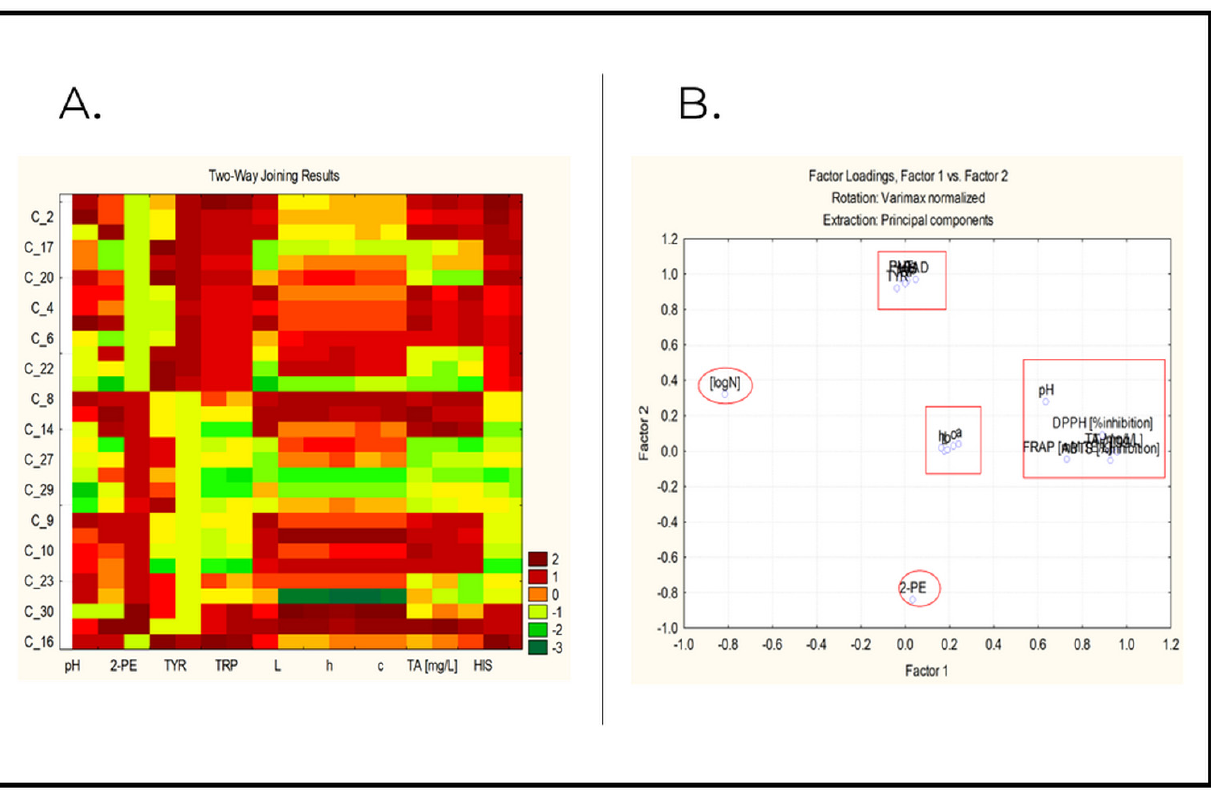
Figure 4. ( A )—Two-way joining plot. ( B )—2D plot of factor loadings. TRP—tryptamine; PUT—pu- trescine; HIS—histamine; TYR—tyramine; CAD—cadaverine; 2-PE—2-phenylethylamine. HIS—histamine; TYR—tyramine; CAD—cadaverine;